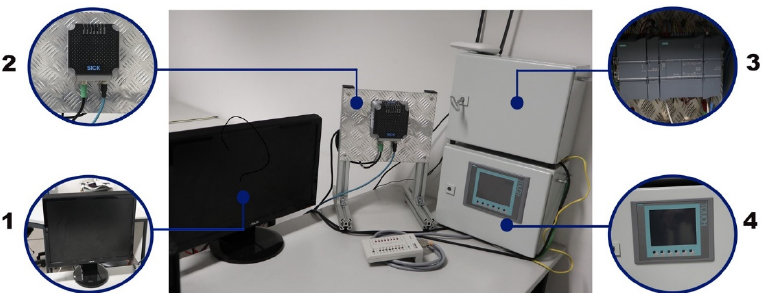
Figure 12. Schematic layout of RFID-System used in the Block-Production Tests.